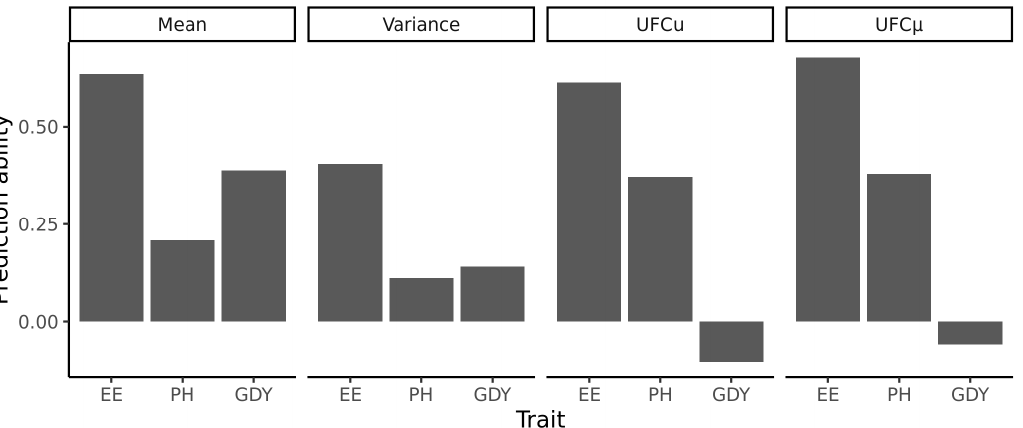
Figure 3. Prediction abilities for the population paramters family means, variances, usefulness criterion ( UFC ) predicted by UFC ( UFCu ) and UFC predicted by the mean ( UFC µ ) for the traits ear emergence (EE), plant height (PH) and grain yield (GDY) with the training set being identical to the test set employing the complete data set of the breeding program.